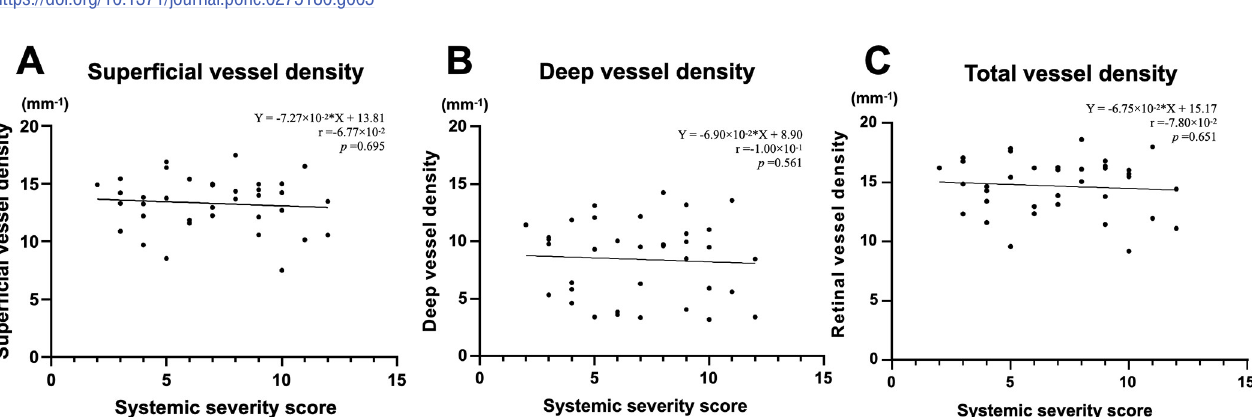
Fig 5. Spearman’s rank correlation analysis showed no significant correlations between perfusion density in various slabs ((A) superficial slab; (B) deep slab; (C) total retinal slab) and the systemic severity score.